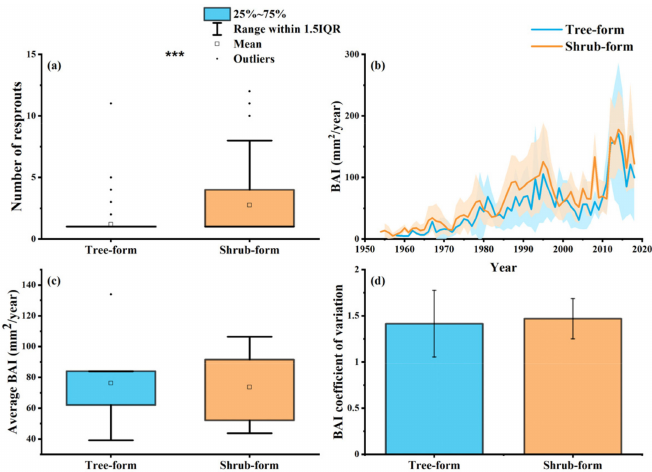
Figure 2. Carbon allocation reflected in growth and reproduction. ( a ), Box plots show the resprout number of different growth form has significant difference (***, p < 0.001). ( b ), Interannual variation in the basal area increment (BAI) of Q. mongolica . Shaded areas are the variations in BAI of average BAI standard variation. ( c ), Box plots show multi-year average BAI of two growth forms have no significant difference ( p > 0.05). ( d ), BAI coefficients of variations have no significant difference between the two growth forms ( p > 0.05). The coefficient of variation ( C.V ) is calculated as the ratio of the BAI standard deviation to the